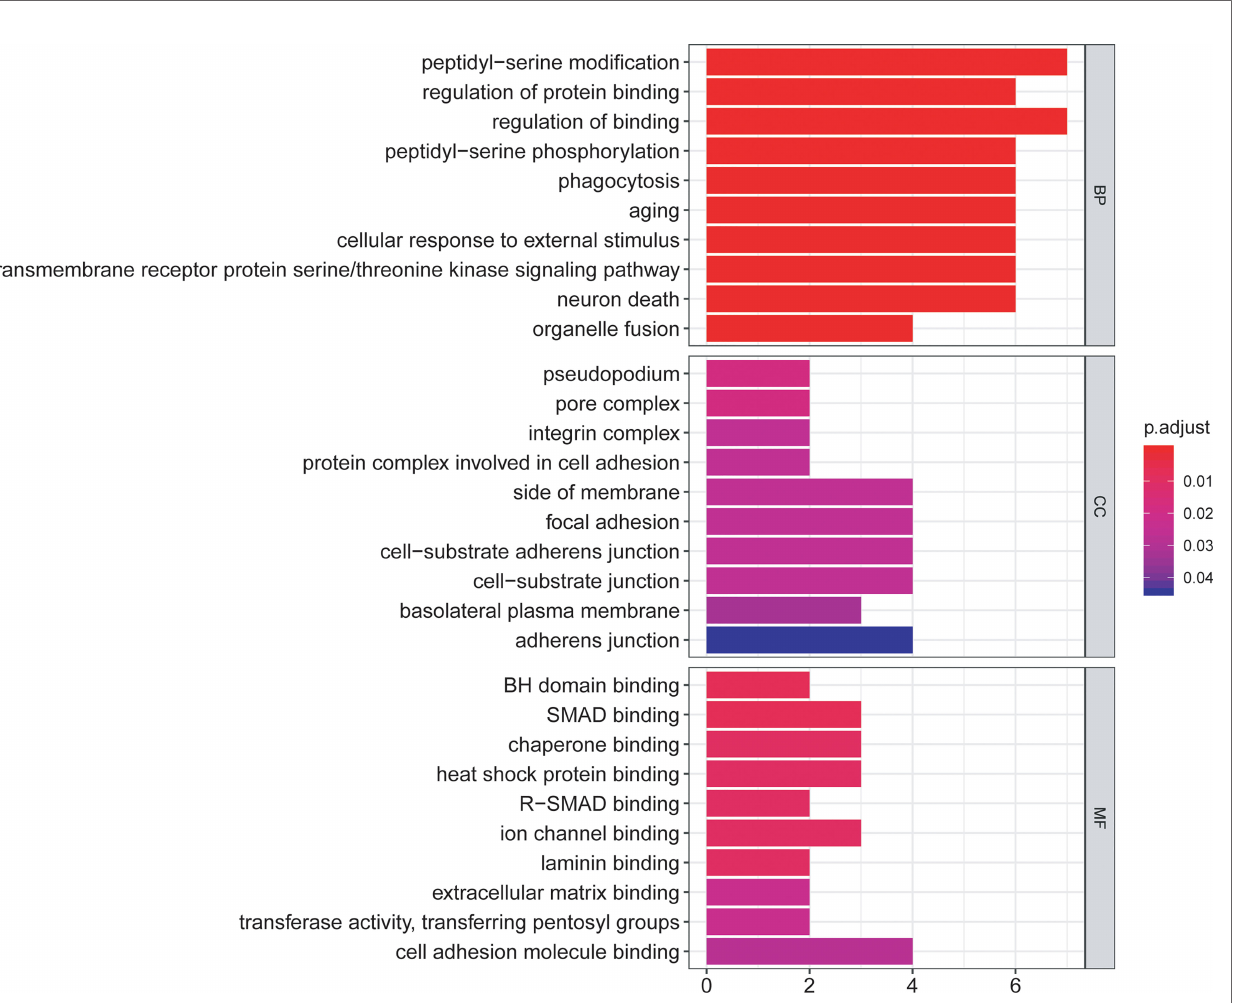
FIGURE 4 | The bar plot of enriched Gene Ontology (GO) terms. BP indicates biological process, CC indicates cellular component, and MF indicates molecular